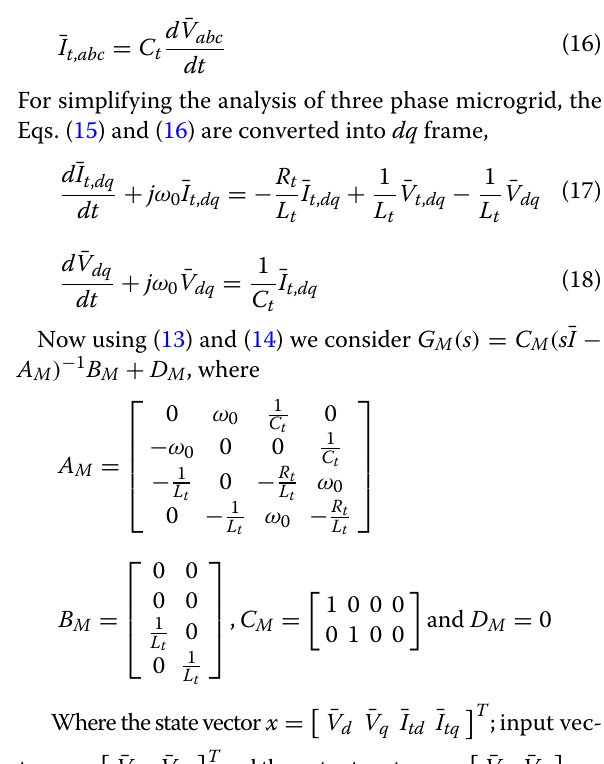
For a linear time invariant system the state